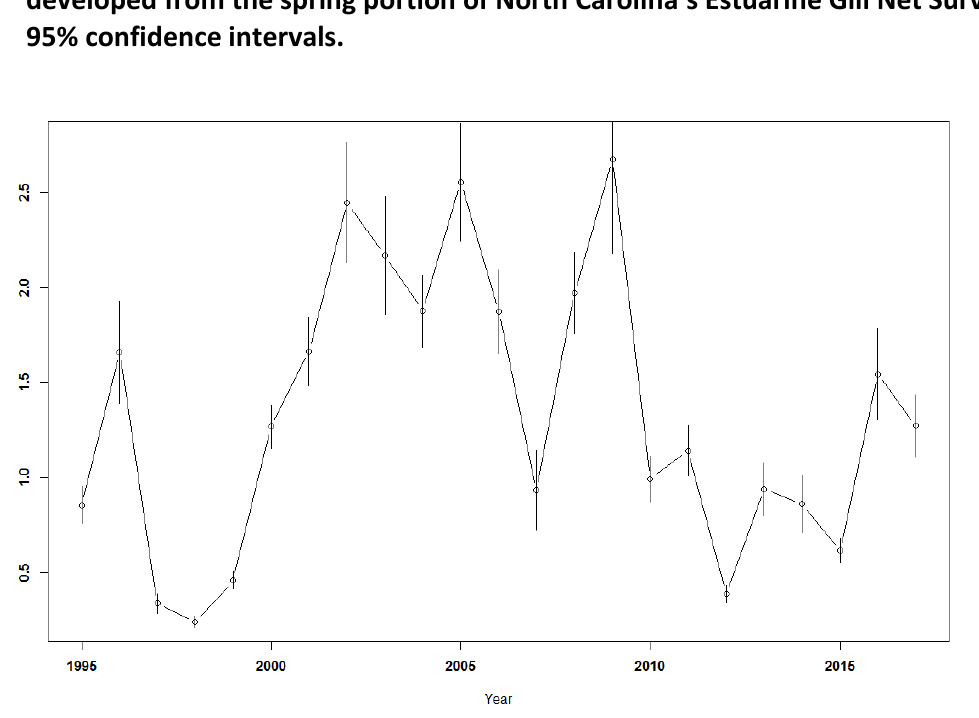
Figure 65. Index of relative abundance of horseshoe crab (delta mean catch per tow) developed from the spring portion of South Carolina’s CRMS with 95% confidence